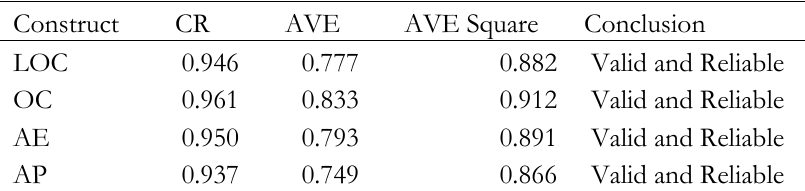
Tabel 1. Measurement of Construct Reliability and